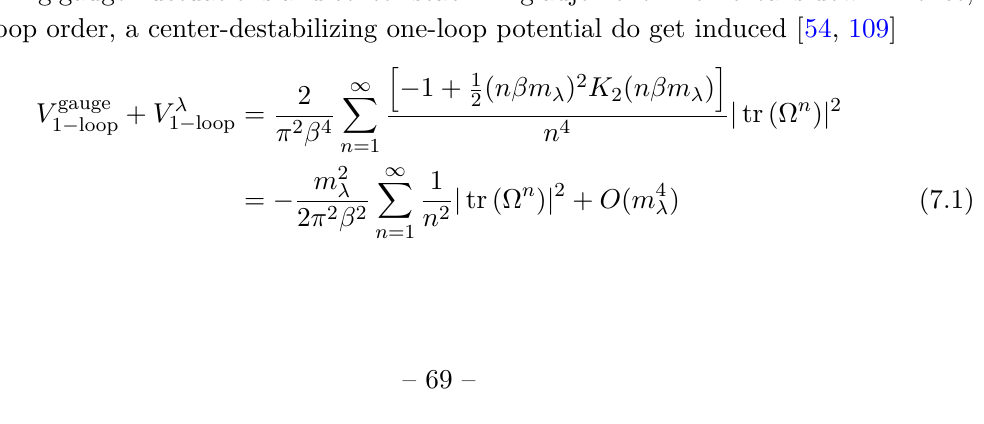
Figure 14 . Analytically calculable (red) and incalculable (black) Z N center or CFC symmetry changing phase transitions in gauge theories on R 3 × S 1 for various values of m a) Z center-symmetry changing phase transition in mass deformed SYM. This is studied in detail N c in [55] and presented here for completeness. b) For heavy fundamental quark with Ω 0 Z CFC symmetry is stabilized for any m N c Yang-Mills theory (with very heavy adjoint and fundamental fermions) between small and large S 1 regimes. c) This theory also exhibits adiabatic continuity for QCD(F) (with very heavy adjoint fermions) between small and large S 1 regimes. See text concerning the blue